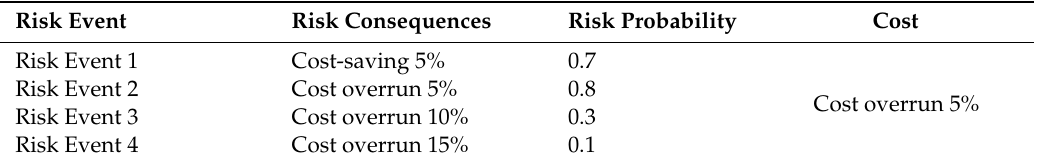
Table 5. Example of risk-related cost using the probabilistic